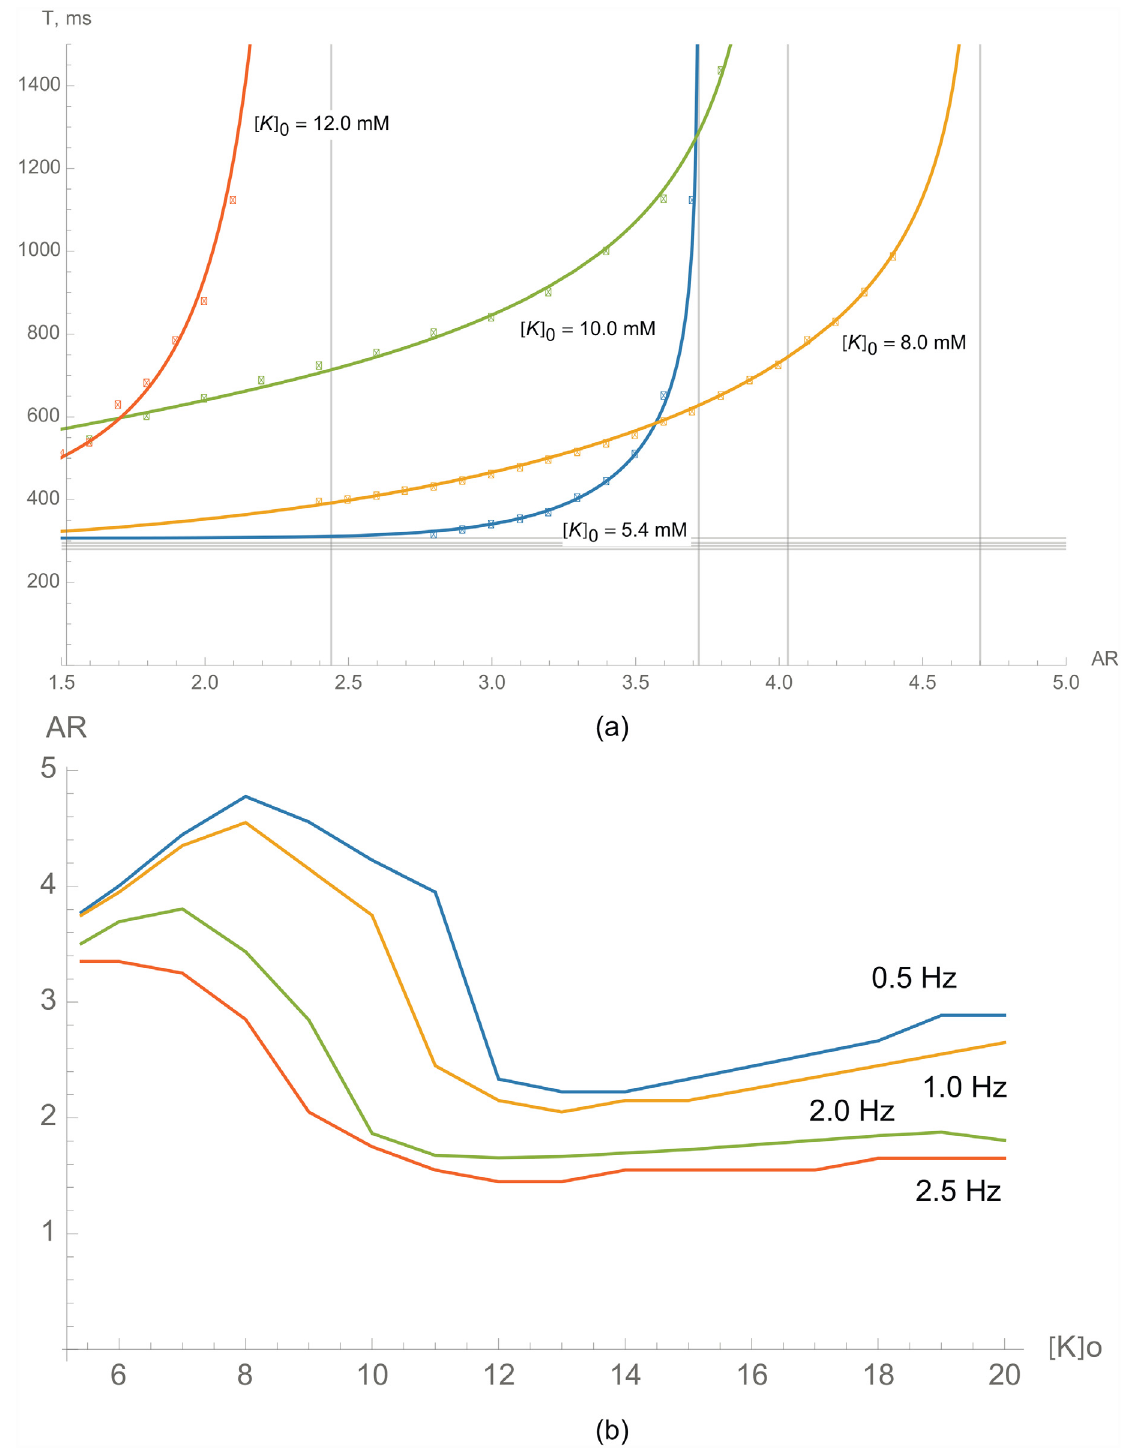
Fig 7. Conditions for waveblock formation in hyperkalemia. a) The dependence of the critical period of stimulation on the AR for various potassium concentrations outside of the cell [ K + ] o . The blue line shows the critical period of stimulation under normal conditions ([ K + ] o = 5.4 mM). b) The dependence of the critical AR on potassium concentration outside of the cell [ K + ] o for various stimulation